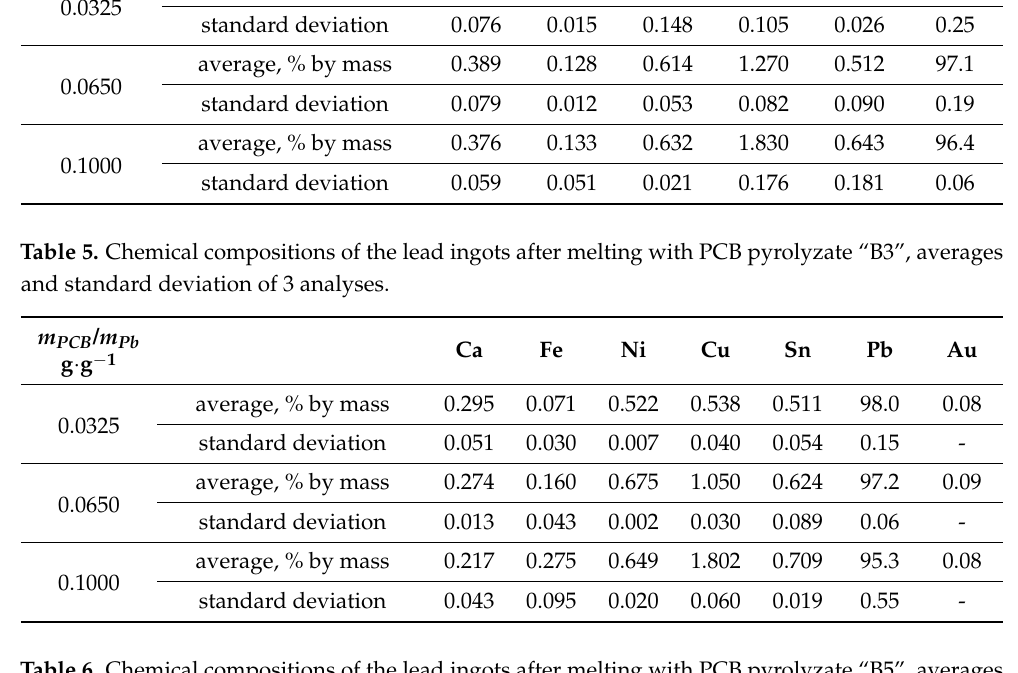
Table 6. Chemical compositions of the lead ingots after melting with PCB pyrolyzate “B5”, averages and standard deviation of 3 analyses.